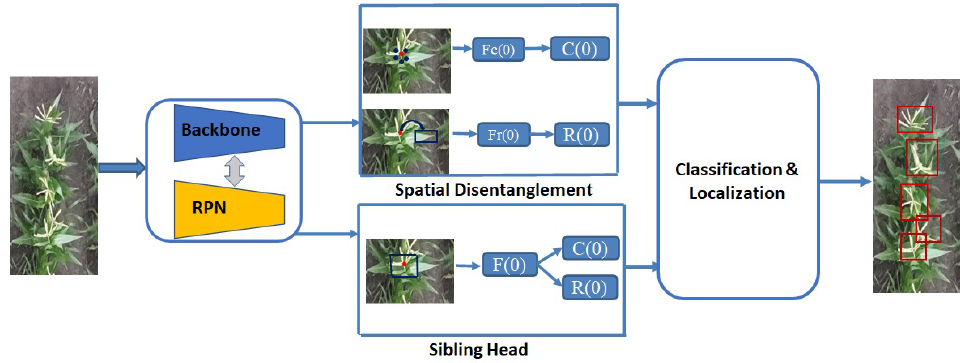
Figure 4. TSD Schematic (ResNext-101).